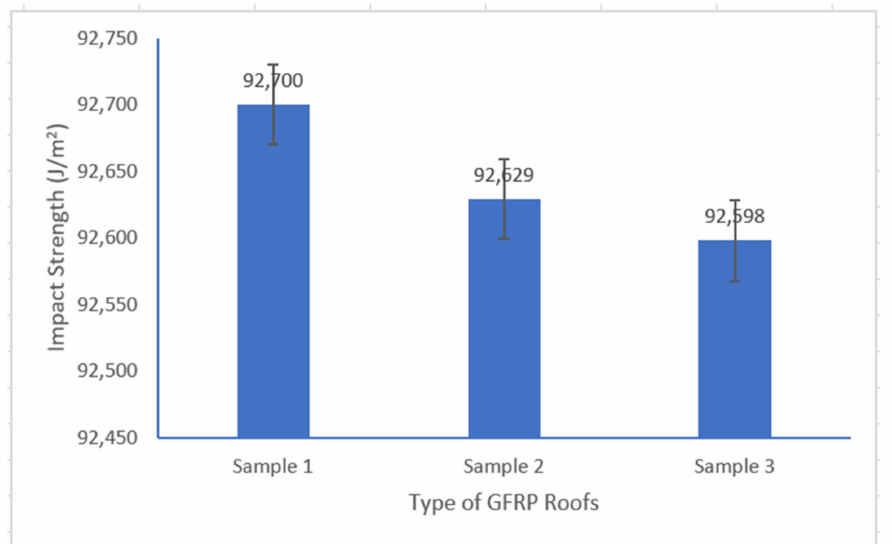
Figure 8. Impact strength of GFRP composite roofs.